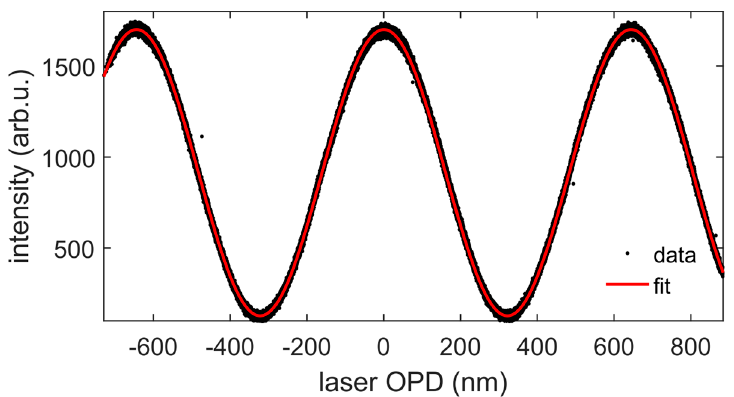
Figure 6. Intensity of the diode laser in the zeroth diffraction order as a function of optical path difference between the gratings of the SDU derived from the WLI images. The red curve is a sine fit to the data.